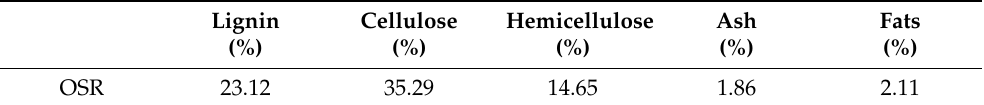
Table 15. Chemical analyses of OSR.